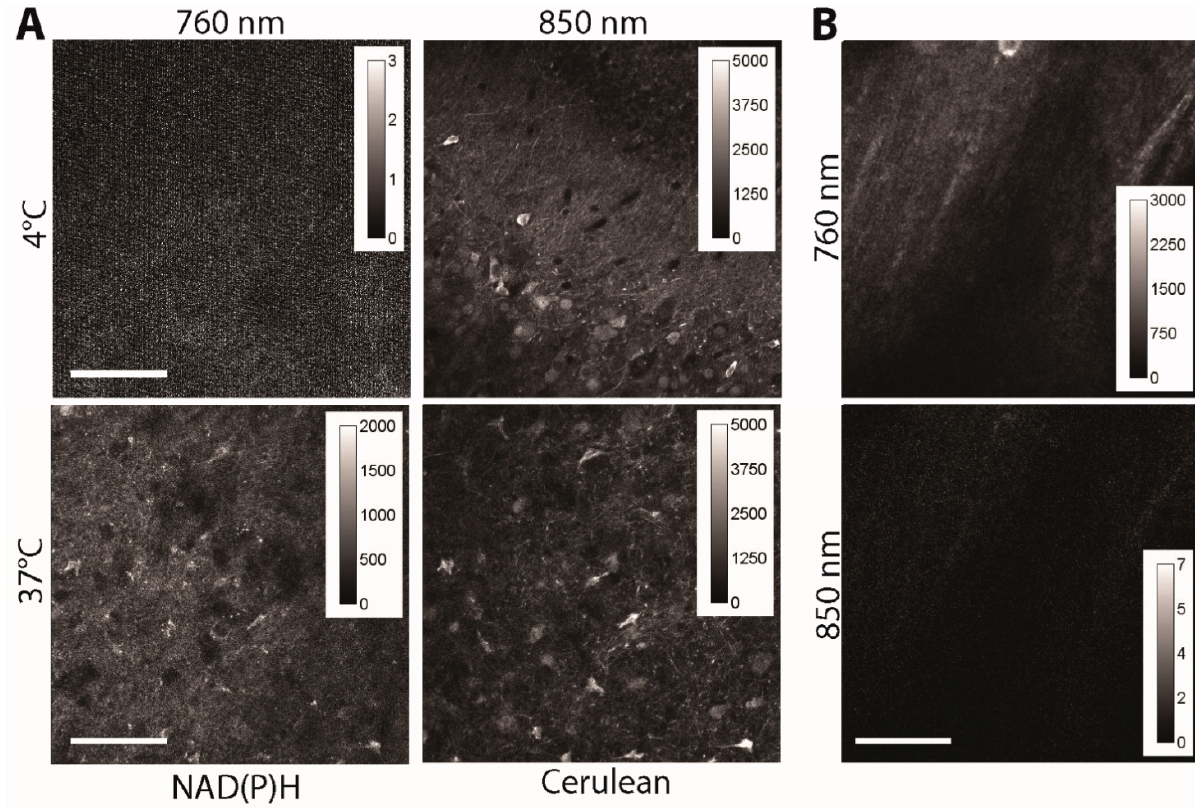
Figure 3. ( A ) Fluorescence signal of 300 × 300 µm areas in acute (live) brain slices of CerTN L15 mice as measured at 760 and 850 nm, respectively. Detection at λ em = 460 ± 30 nm. The temperature was set at 4 and 37 °C, to decrease the NAD(P)H metabolism at a minimum (4 °C) and to increase it at physiological levels (37 °C), respectively. Since at 4 °C only free NAD(P)H of a much shorter fluorescence lifetime is detected, the fluorescence intensity under excitation at 760 nm is very low (NAD(P)H fluorescence representing the integral under the decay curve), whereas under excitation at 850 nm it appears at high levels (Cerulean). At 37 °C NAD(P)H is mostly involved in metabolic processes, i.e. , is bound to enzymes, and shows an up to 10 times longer fluorescence lifetime as free NAD(P)H. Under these conditions, both under excitation at 760 nm and at 850 nm, high fluorescence signals are detected. The laser peak photon flux at the sample was kept constant for all experiments to ensure an accurate comparison; ( B ) Fluorescence signal of 300 × 300 µm 2 areas in acute (live) brain slices of C57/B6 mice (wild-type) as measured at 760 and 850 nm, respectively. Detection at λ em = 460 ± 30 nm. Scale bar = 100